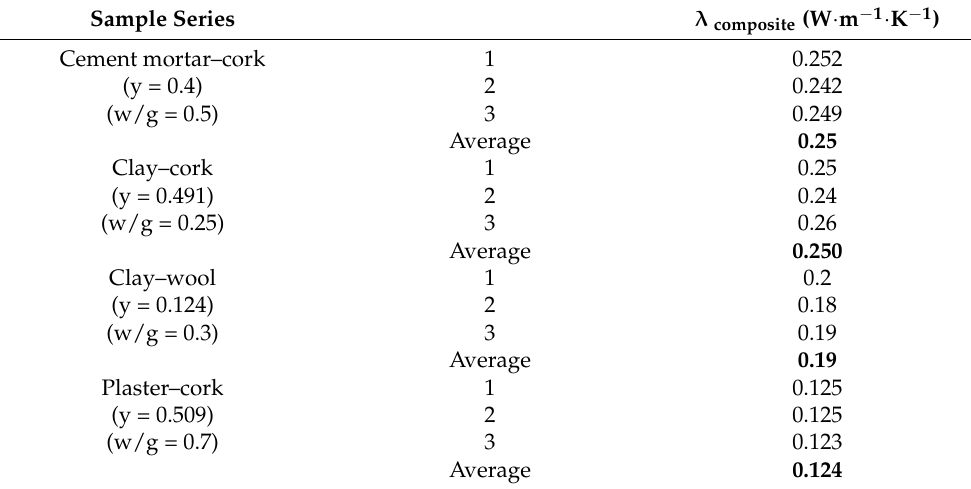
Table 4. Results of thermal conductivity of the tested samples of the composites. Sample Series